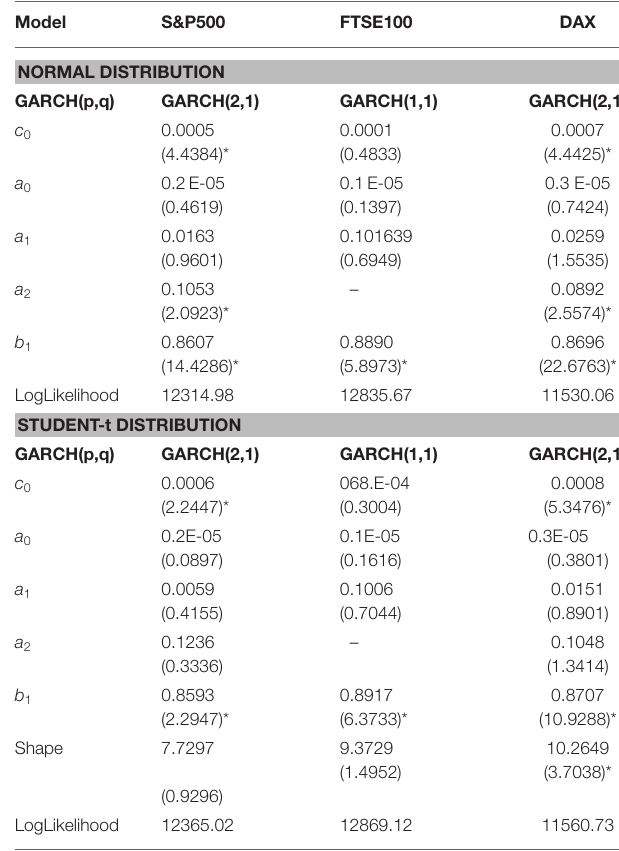
TABLE 3 | Values of SBC and AIC criteria for all models. TABLE 4 | Parameter estimates of symmetric GARCH(p,q) models for three equity indices using the entire data set and assuming two alternative distributions for the residuals, t-statistics are presented in